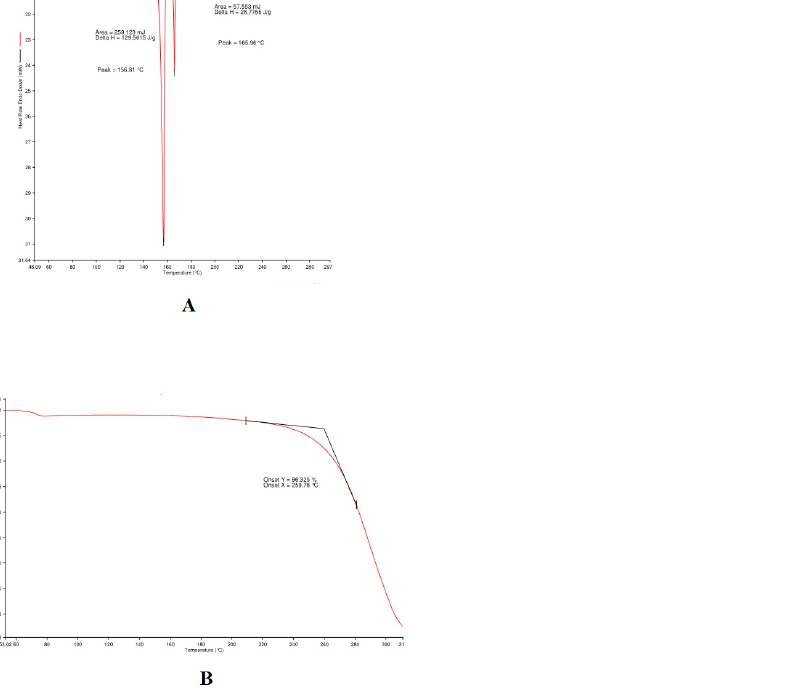
Figure 3. Physical characterization of lyophilized recombinant HBsAg-loaded docosahexaenoic acid nanovesicles; ( A ) differential scanning calorimetry study; ( B ) thermo gravity analysis .